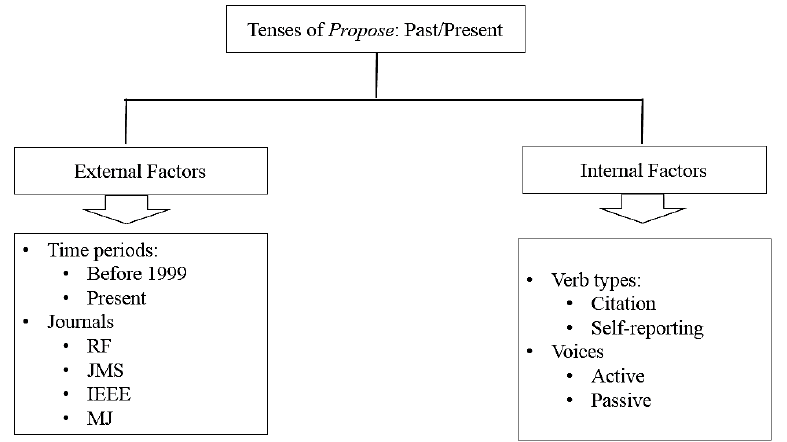
Figure 1. Data analysis